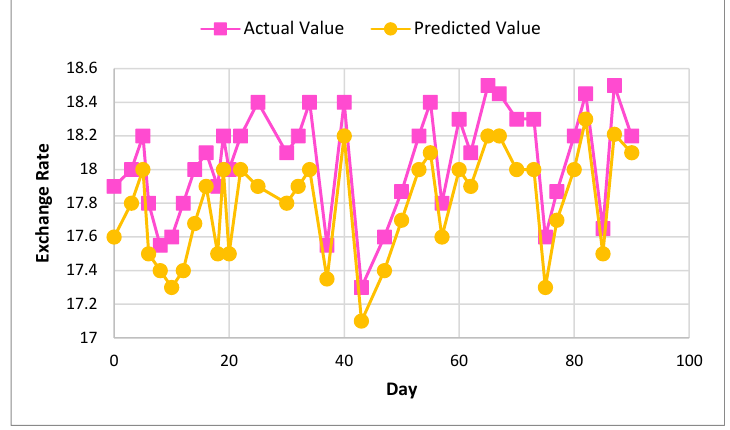
Figure 9. Actual and predicted value of Litecoin using XGBoost for 90 days.